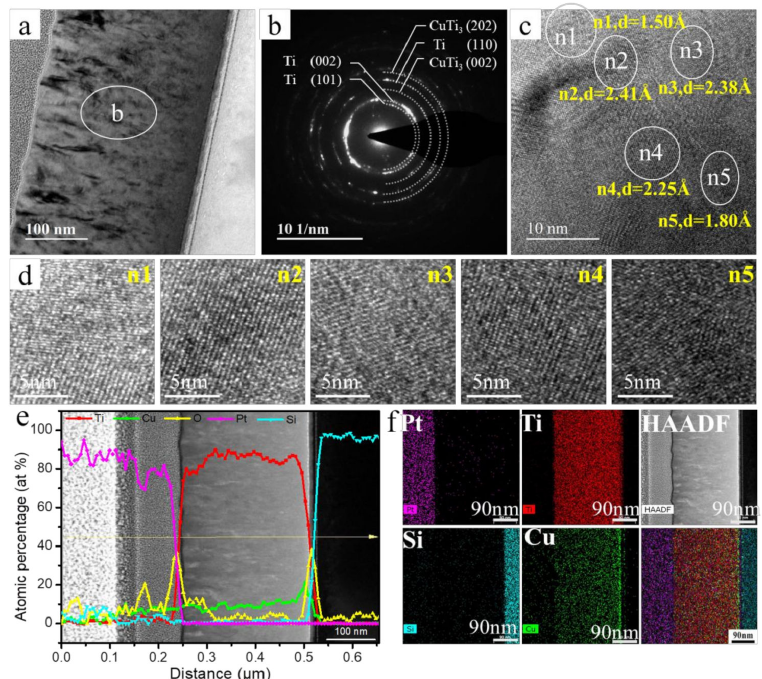
Figure 3. Cross-sectional transmission electron microscopy (TEM) results obtained for the as-deposited Ti–Cu coatings on silicon substrates: ( a ) low magnification field image; ( b ) selective area electron di ff raction (SAED) image; ( c , d ) high-resolution transmission electron microscopy (HRTEM) images; ( e ) EDS line scans showing the distributions of elements (Pt, Ti, Si, Cu, O) in the high-angle annular dark-field (HADDF) image; ( f ) corresponding EDS mappings showing the distribution of elements (Pt, Ti, Si, Cu) in the HADDF